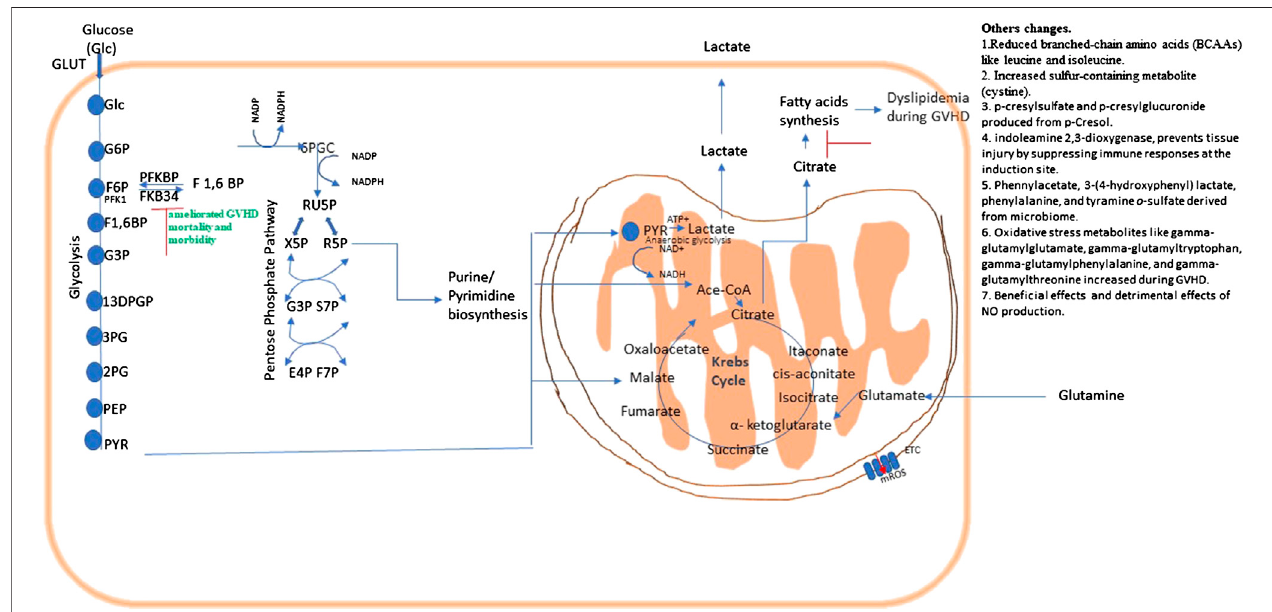
FIGURE 5 | Metabolic pathways and their possible therapeutic approach in graft vs. host disease (GVHD). Energy or ATP generation in cells involve fundamental cellularprocessesglycolysisandOXPHOS.GlycolysisinterconnectswithKreb ’ scycleandthePPP,whichisnecessaryforfundamentalmetabolicprocess,andNADPH regeneration. Metabolic changes in a pathway may consequently affects others as they are all